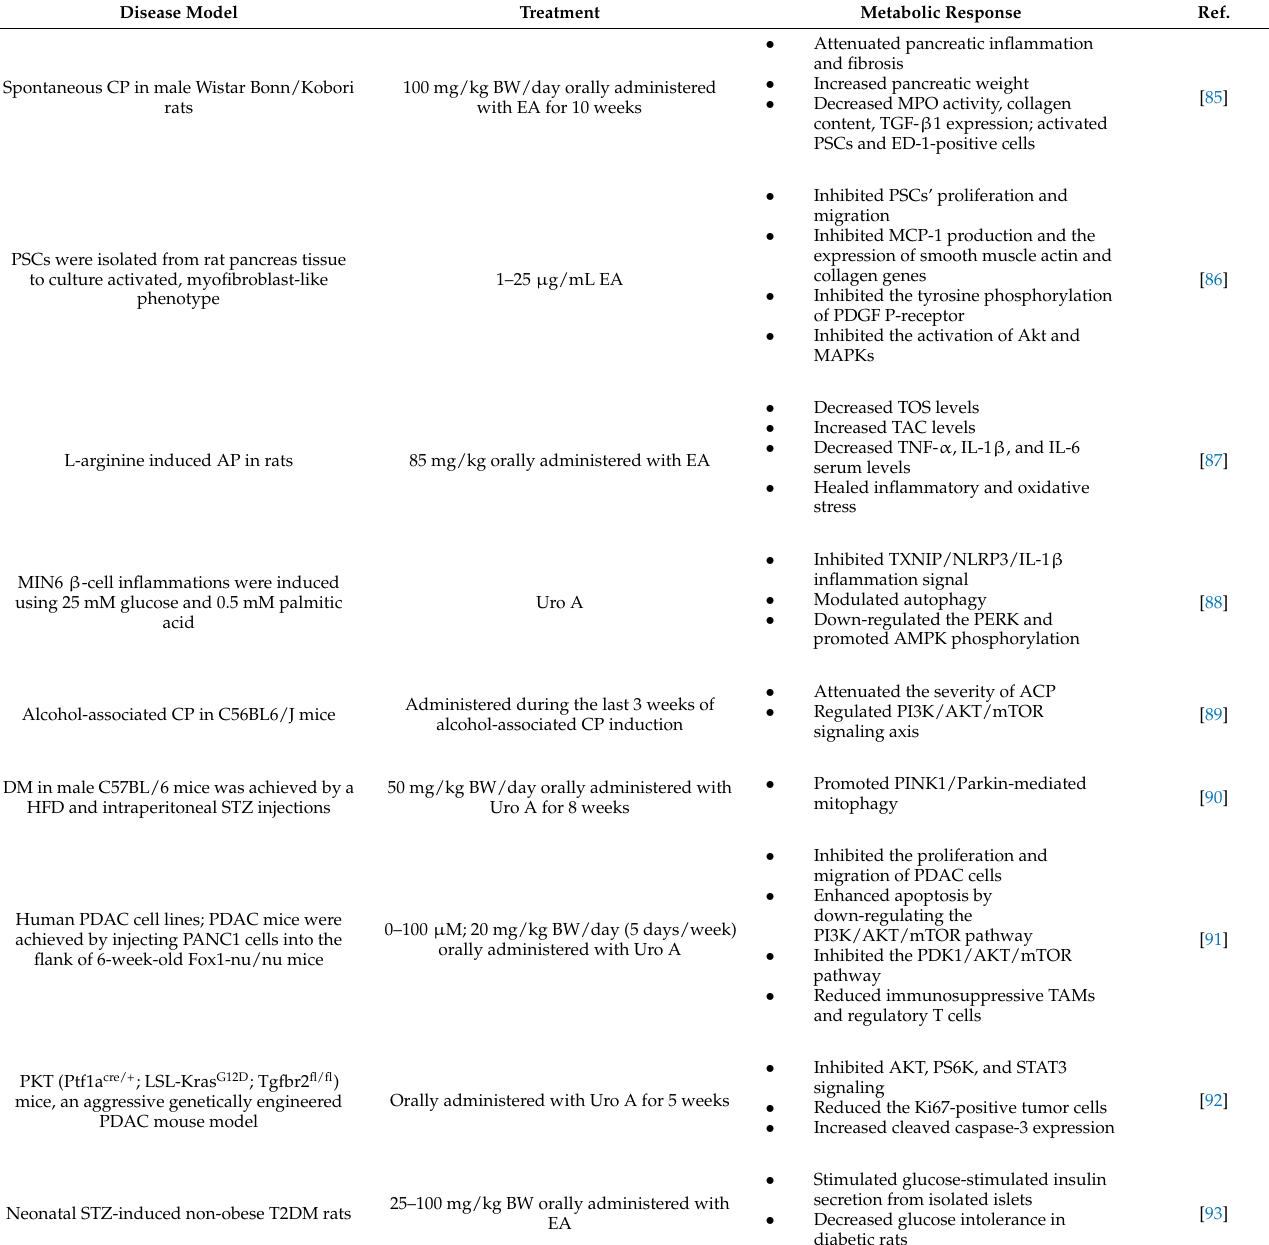
Table 1. Potential effects and mechanisms of urolithin A and its precursor compounds EA on pancreatic